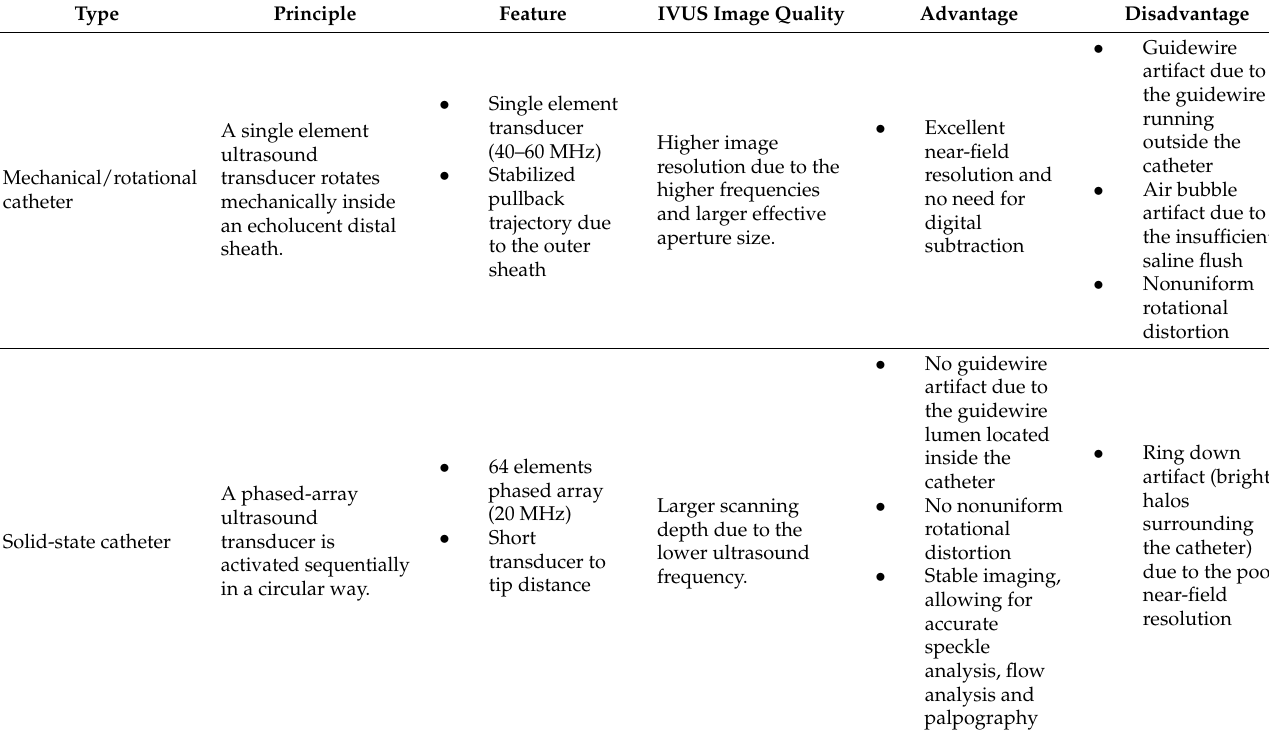
Figure 3. Two different types of IVUS catheters: ( a ) mechanical/rotational catheter with a single-element ultrasound transducer; ( b ) solid-state catheter with a phased-array ultrasound transducer. Reprinted with permission. (Figure courtesy: Boston Scientific, Inc., Marlborough, MA, USA, https://www.bostonscientific.com, accessed on 6 January 2021). Table 3. A comparison of mechanical/rotational catheter and solid-state catheter.